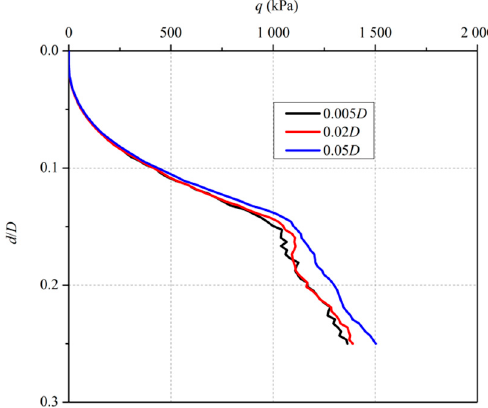
Figure 5. Penetration resistance profiles for different mesh sizes.